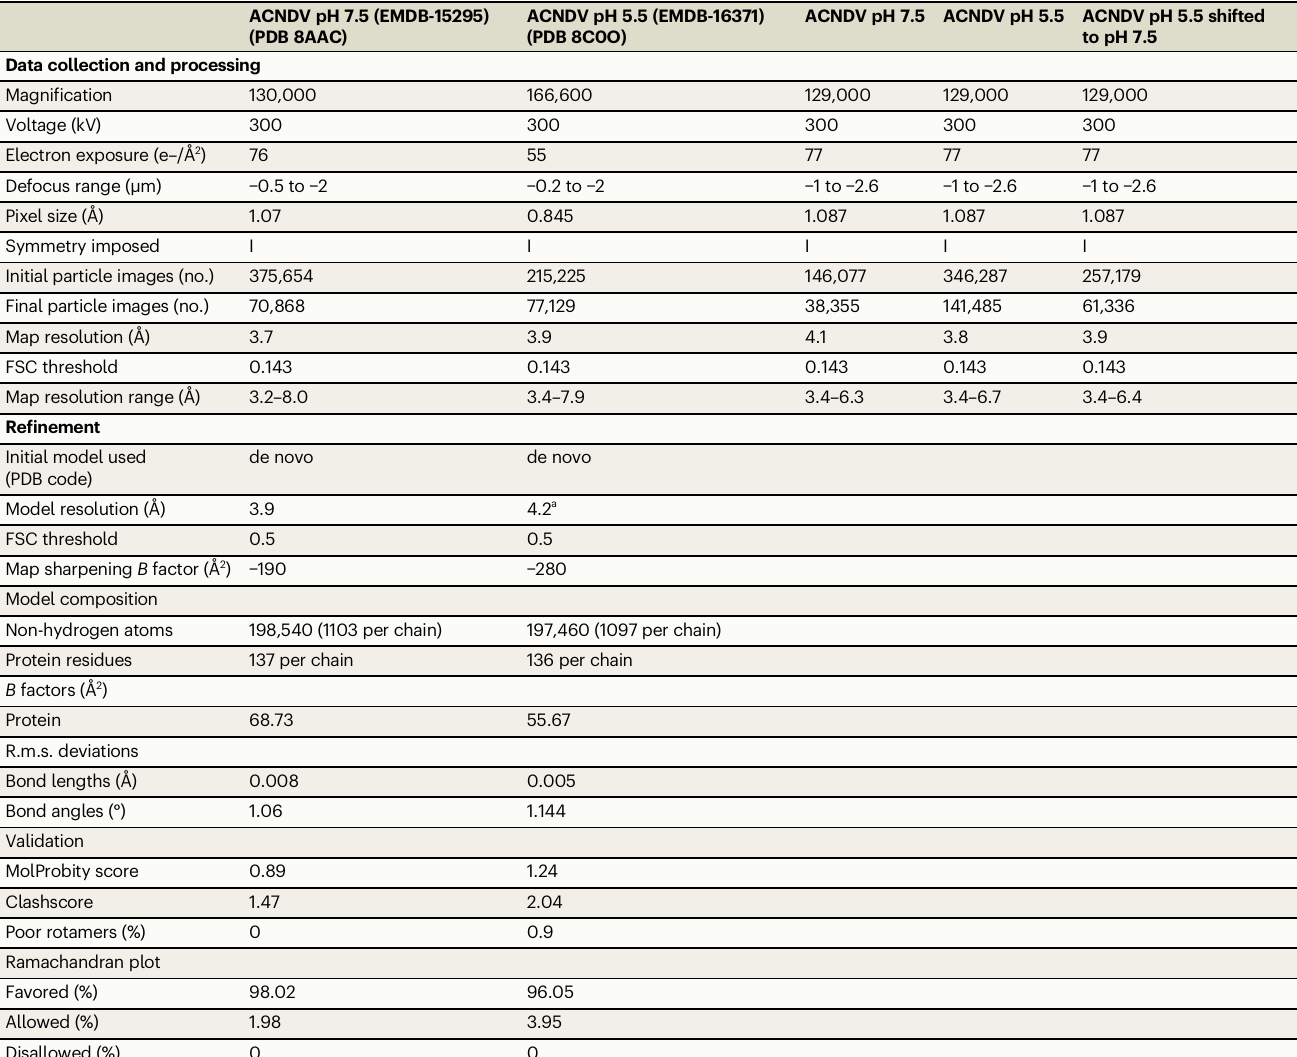
Table 1 | Cryo-EM data collection, re fi nement and validation statistics ACNDV pH 7.5 (EMDB-15295) (PDB